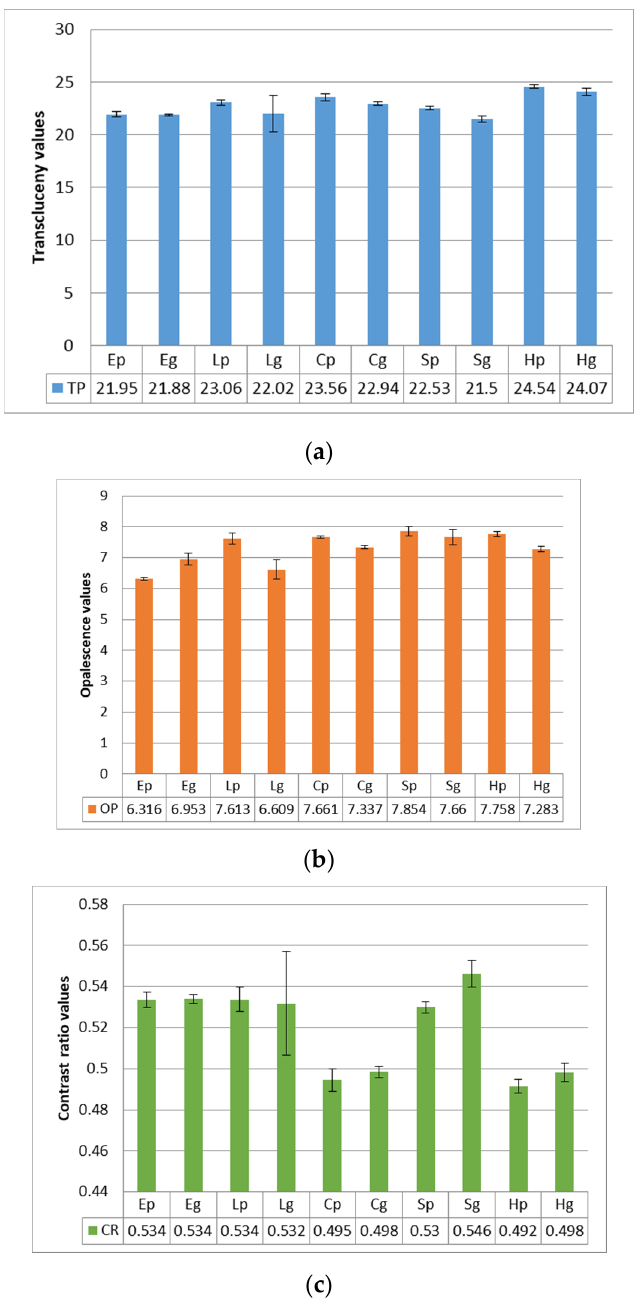
Figure 1. ( a ) Transclucency parameter average values of the tested samples with different try-in paste and substrate. ( b ) Opalescence parameter average values of the tested samples with different try-in paste and substrate. ( c ) Contrast ratio parameter average values of the tested samples with different try-in paste and substrate.